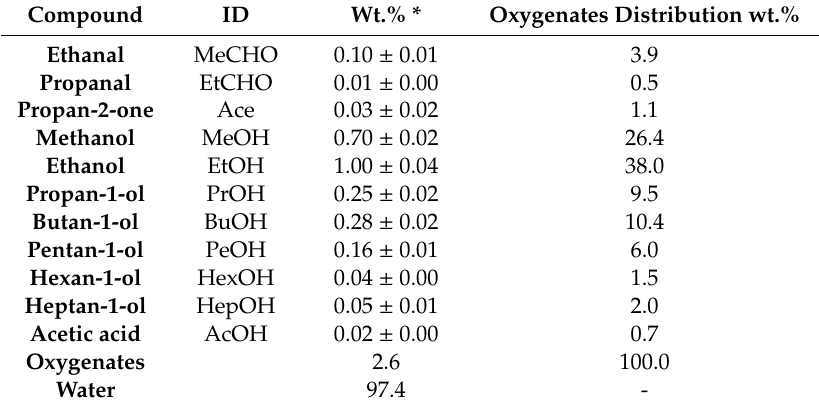
Table 2. Chemical composition and concentration of organic compounds in the Fischer–Tropsch (FT)